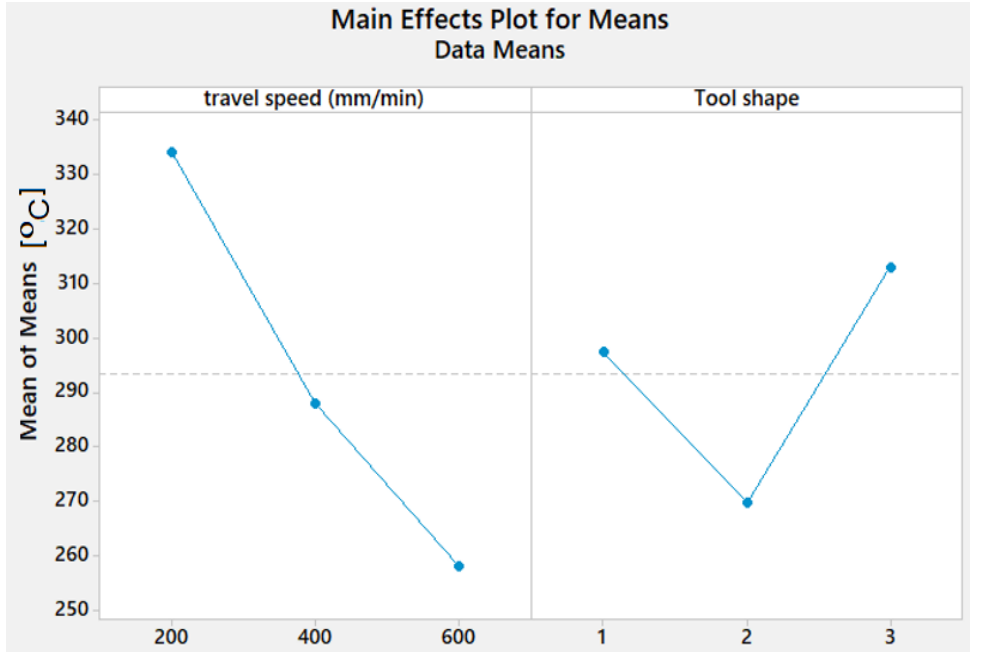
Figure 4. Effect of process parameters on the Tw of AA1050 thick lap joints.